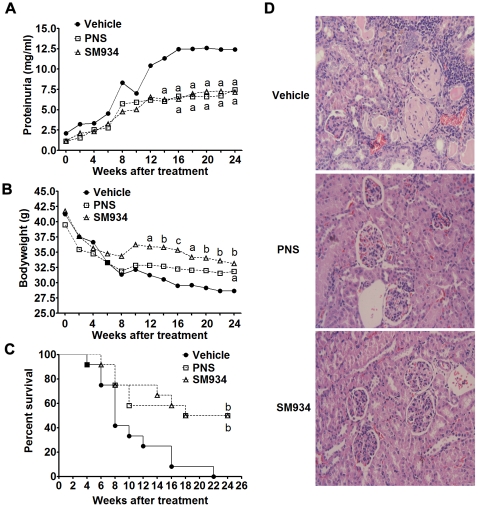
SM934 treatment for 6 months significantly prevented fatal nephritis and prolonged the lifespan.Six and half months old female NZB/W F1 mice were orally treated with vehicle, SM934 (10 mg/kg), and PNS (2 mg/kg) for 6 months (n = 12 per group). (A and B), The levels of proteinuria (A) and bodyweight (B) were measured every two weeks. (C) Cumulative survival rate during 6 months of treatment. (D) Histology of representative kidney sections stained with H&E (Original magnification×200). In A, B and C, a = P<0.05; b = P<0.01; c = P<0.001 versus vehicle.